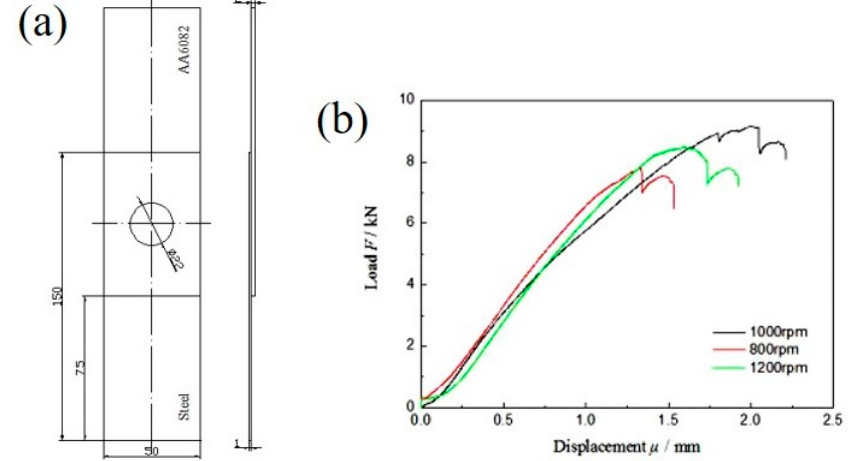
Figure 2. Drawing ( a ) and load-displacement curve ( b ) of tensile-shear specimen of dissimilar Al/steel keyhole-free FSSW joints.